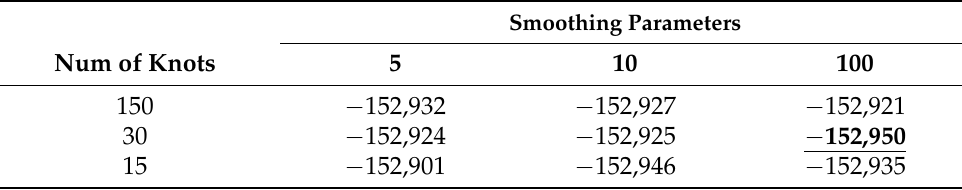
The best of each distribution is underlined, and the best overall is in bold. Table 7. DIC for Gamma distribution (27 July 2016, TMC, Aichi, Japan).